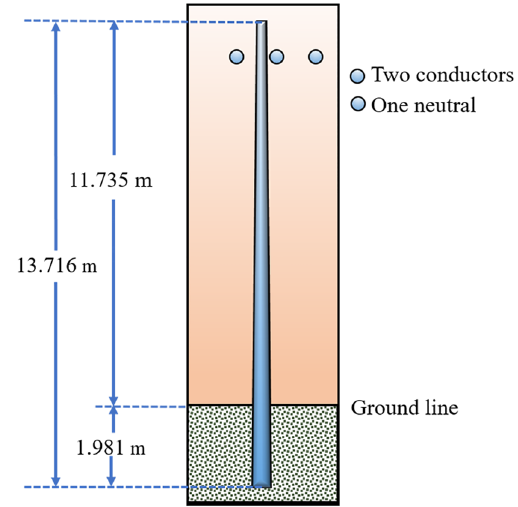
Fig. 4 Layout of a single-phase line utility